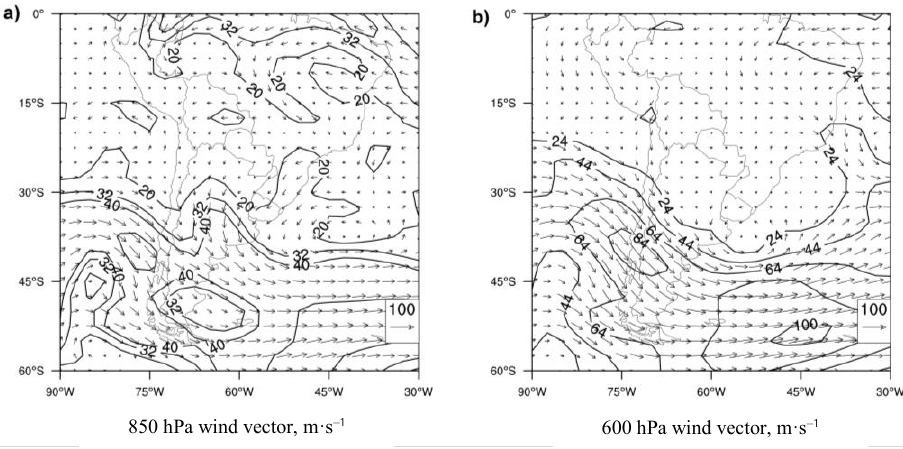
Fig. 5. Average wind speed (contour) and direction (arrows) for 8 January 2012 at: a) 850 hPa; b) 600 hPa. Figure built from images provided by the Earth System Research Laboratory of the National Oceanic and Atmospheric Administration, Boulder, Colorado, on its website [72].